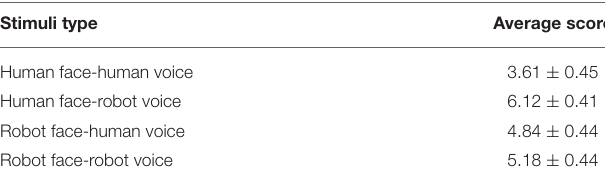
TABLE 1 | Average uncanniness scores of audio-visual stimuli.